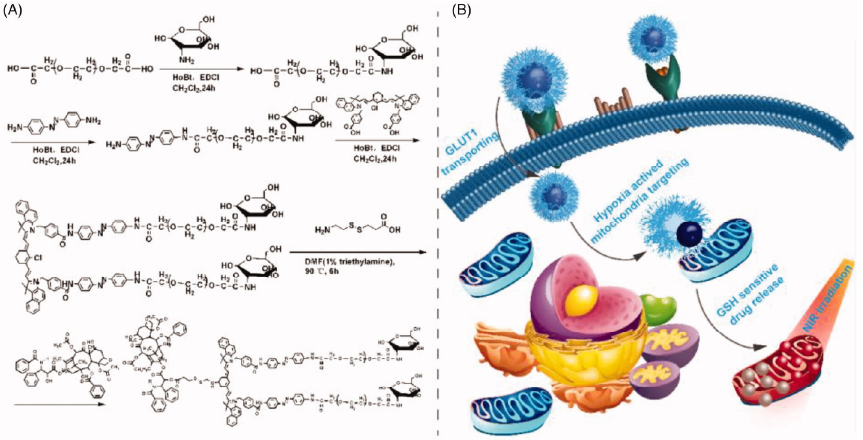
Figure 4. ( A ) The synthetic process of Glu-PEG-Azo-IR808-S-S-PTX conjugate; ( B ) its action mecha- nism after self-assembled into micelle. Abbreviations: Glu: glucose; Azo: azobenzene; PTX: Paclitaxel. Reprinted with permission from ref. [127]. Copyright 2021, published by Informa UK Limited, trading as Taylor & Francis Group.